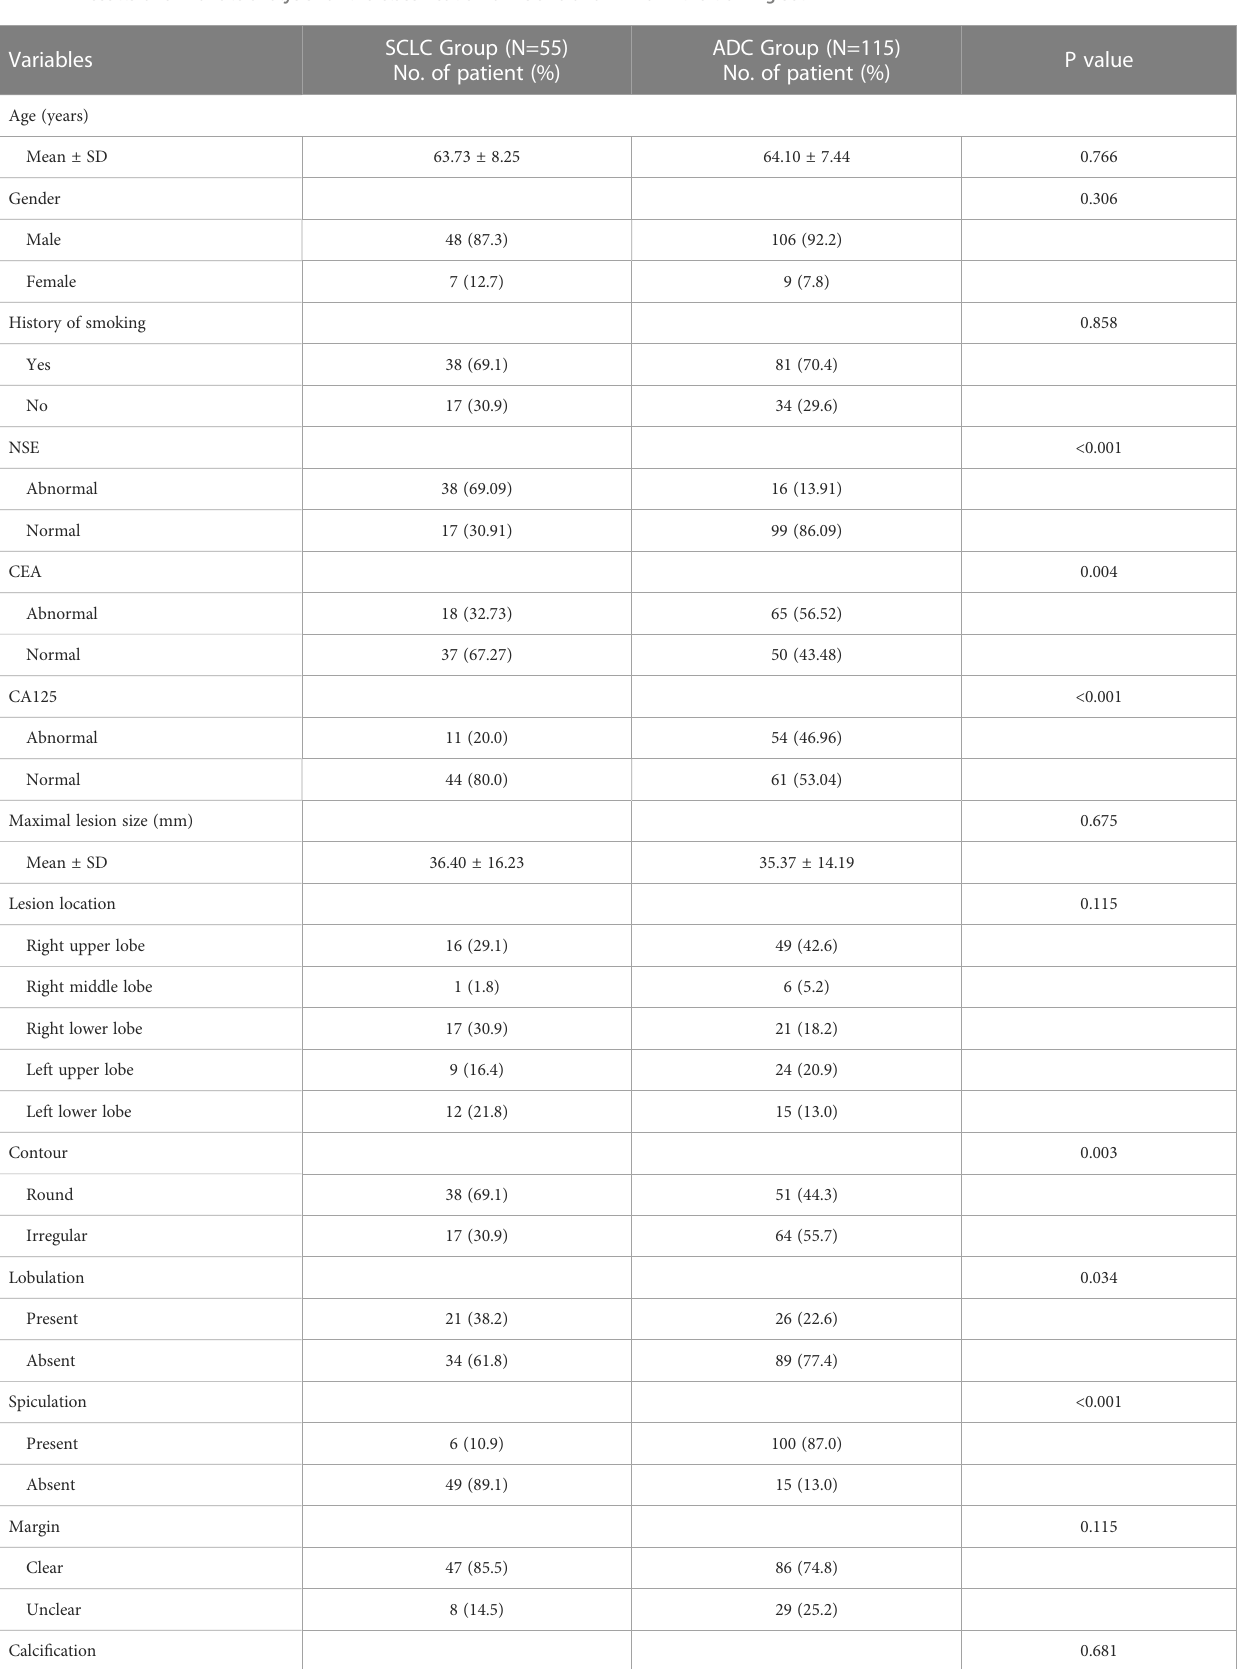
TABLE 2 Results of univariate analysis for the classi fi cation of PSCLC and PADC in the training set.